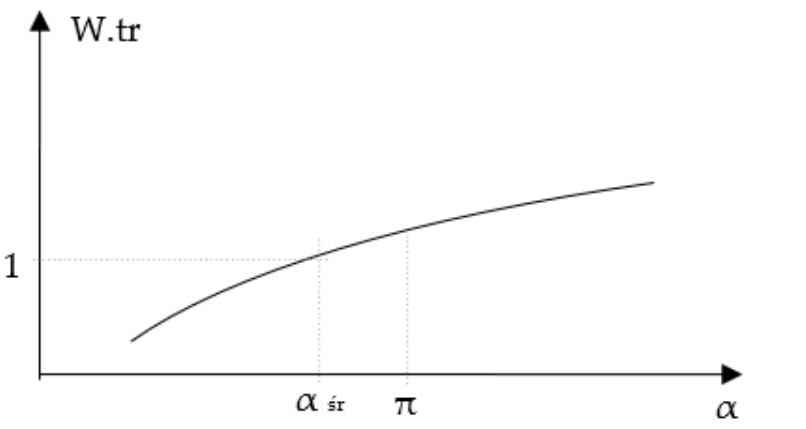
Figure 1. Dependence of the coefficient of difficulty on the change of direction (deviation angle = 1 / 2 α ).